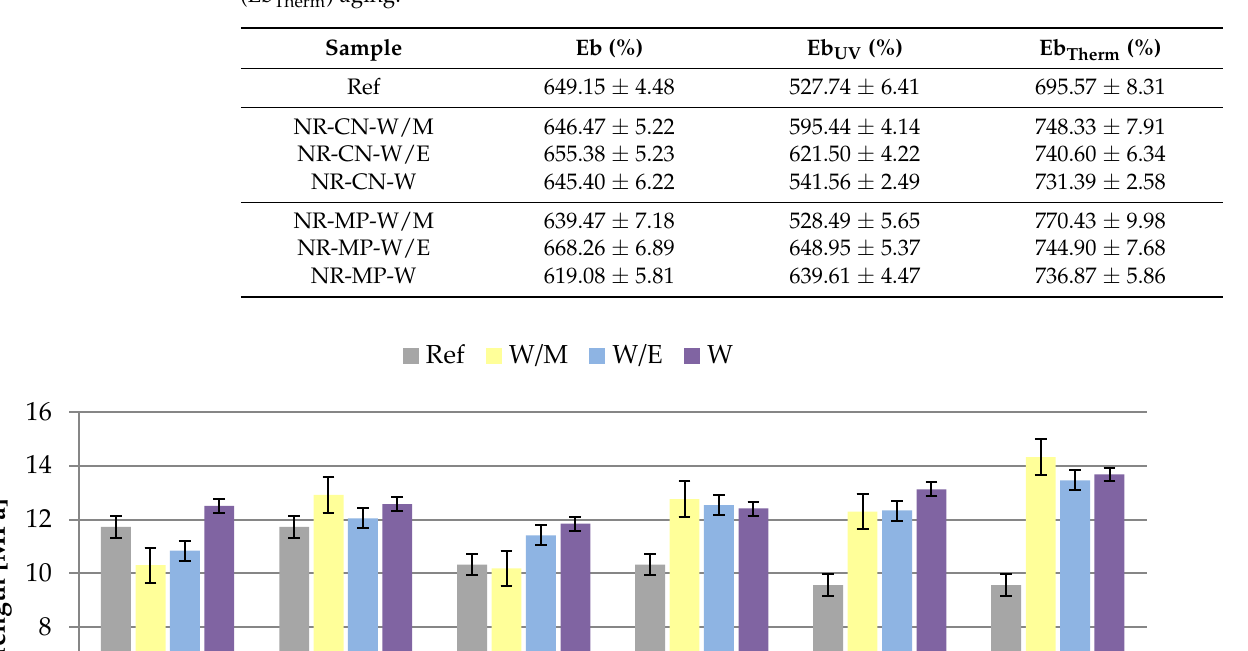
Table 7. Elongation at break before (Eb) and after ultraviolet (Eb UV ) and thermo–oxidative (Eb Therm ) aging.